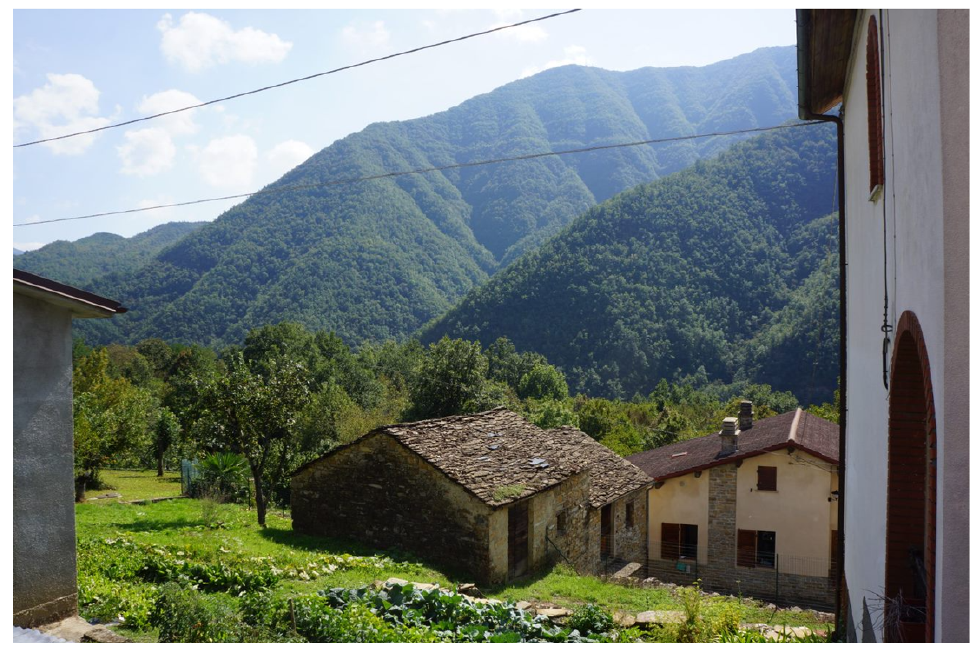
Figure 3: Abandoned rural constructions in the municipality of